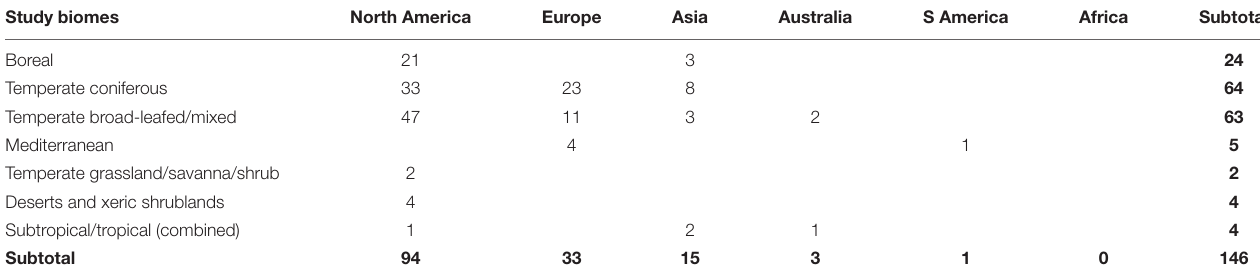
TABLE 2 | Geographical distribution of disturbance interactions studies covered by the systematic review ( Supplementary Materials ).